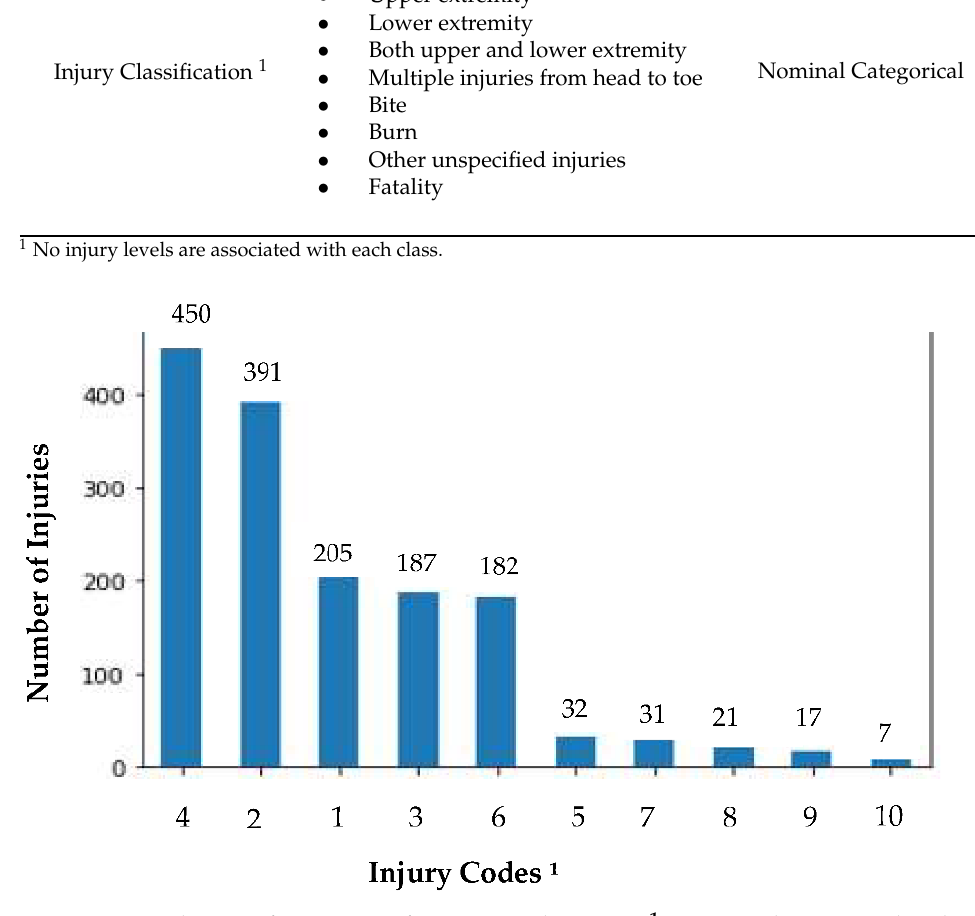
region; 2. Torso and Hands region; 3. Upper extremity; 4. Lower extremity; 5. Both upper and lower ex-